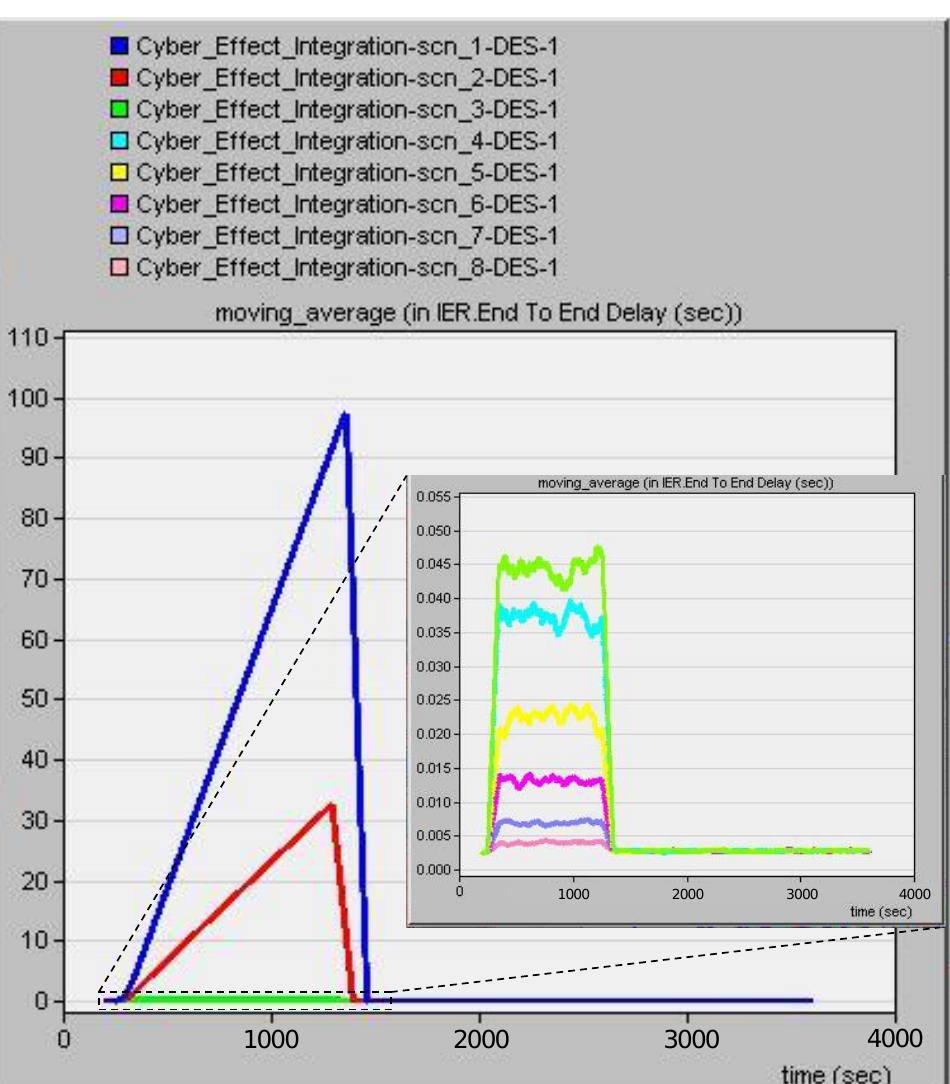
Figure 15. End-to-end IER transmission delay according to the DDoS attack volume.